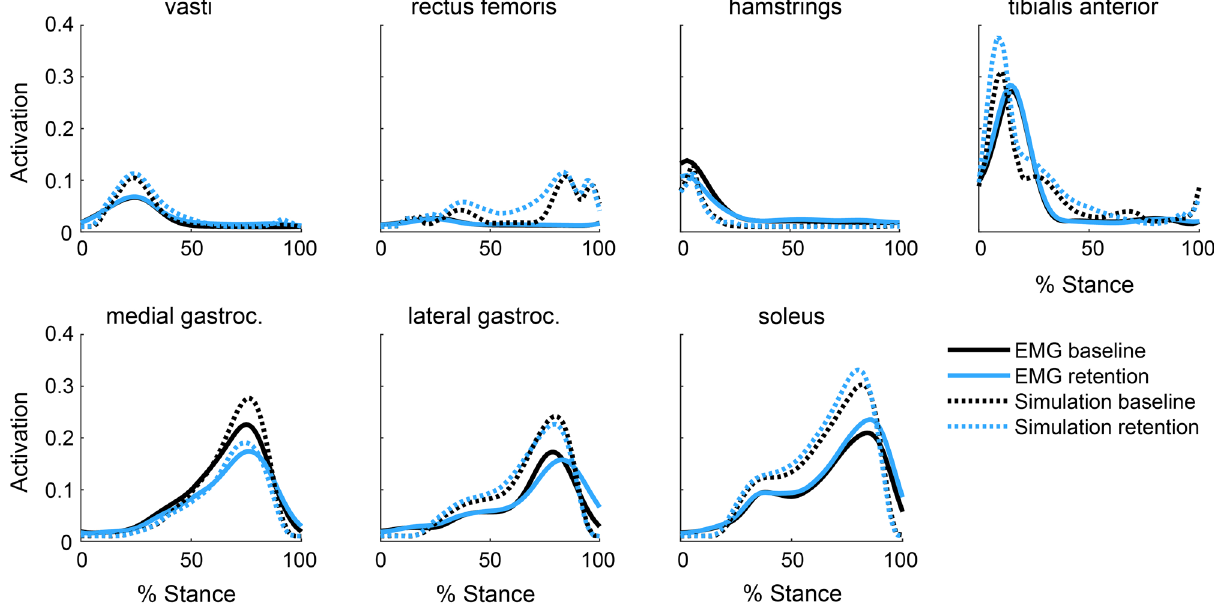
Figure 5. Simulated and measured muscle activation. Electromyography (EMG) linear envelopes averaged across all participants (n = 10) with a 40 ms electromechanical delay are compared to simulated muscle activations for the baseline and retention trials. Despite magnitude differences between EMG and simulated activations of the gastrocnemius and soleus, the relative changes between trials are consistent, indicating that our EMG-informed static optimization technique captured the changes in ankle plantarflexor muscle activity measured with EMG. The activations of the muscles in the top row were not informed by EMG in the simulation. The shape, timing, and between-trial changes in simulated activation matched EMG for these muscles, with the exception of the rectus